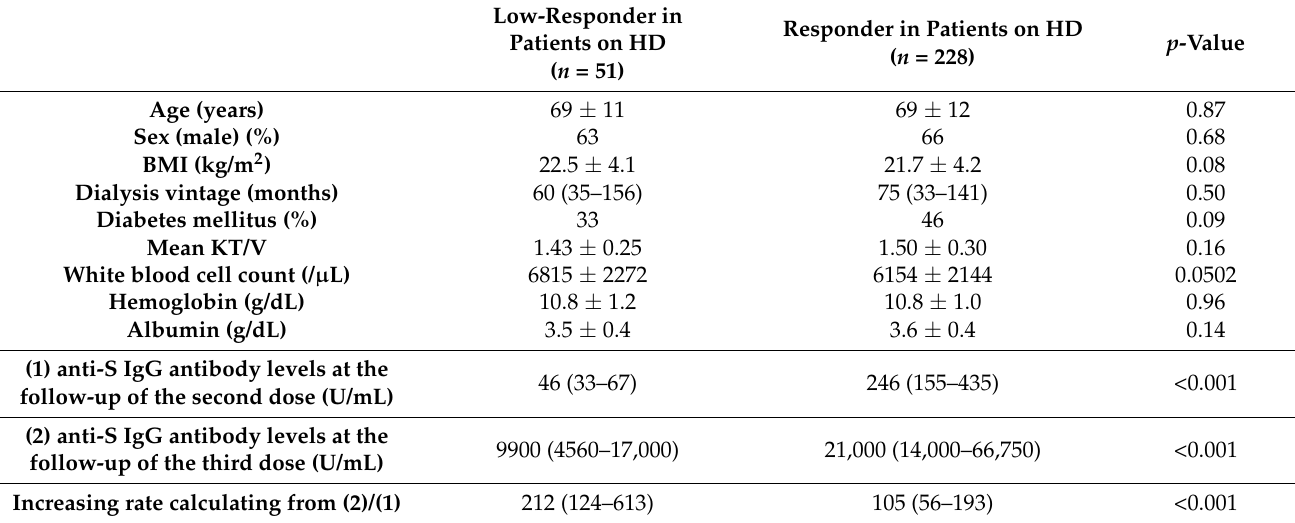
Table 3. Difference between low responder and responder in patients on maintenance